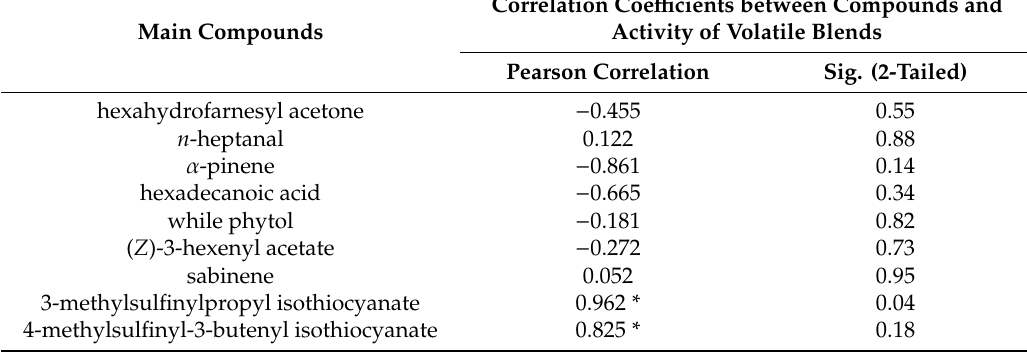
* Correlation coe ffi cients with significant di ff